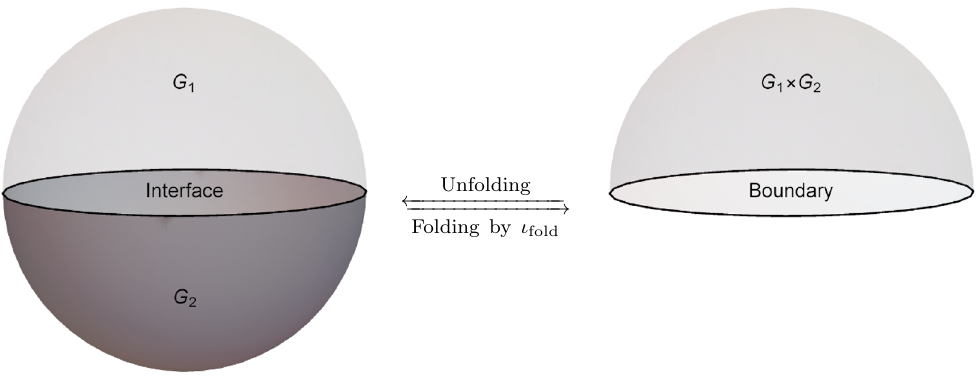
Figure 2 . The (un)folding trick that relates interface between G 1 and G 2 SYM and boundary condition for G 1 (cid:2) G 2